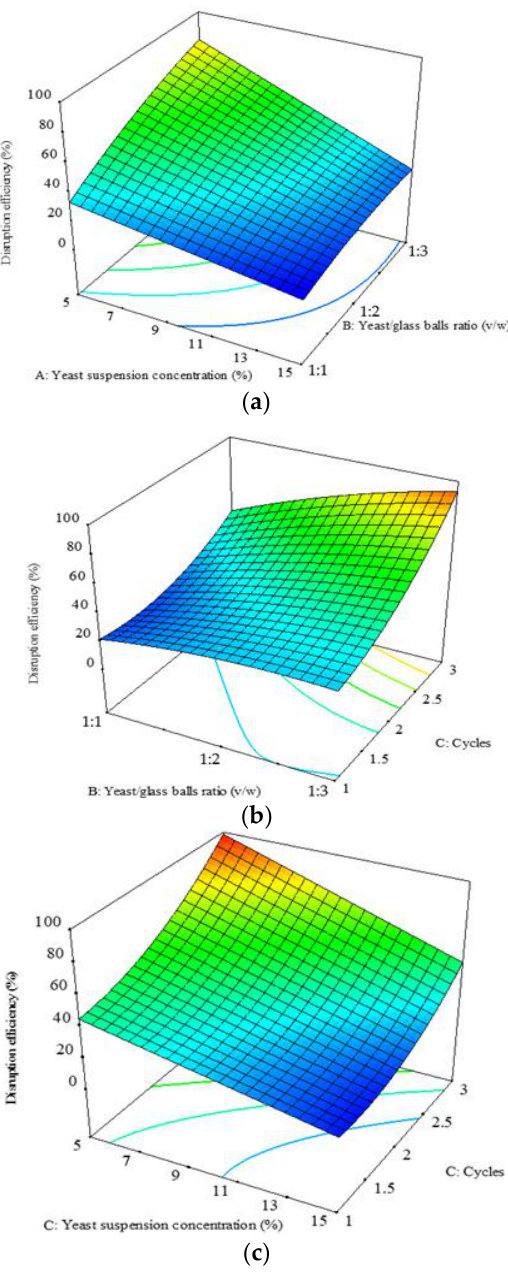
Figure 2. 3-D plots of combined effects of factors: ( a ) yeast suspension concentration (A) and yeast/glass beads ratio (B), ( b ) yeast/glass bead ratio (B) and number of cycles (C), ( c ) yeast suspension concentration (A) and number of cycles (C) on cell disruption efficiency.